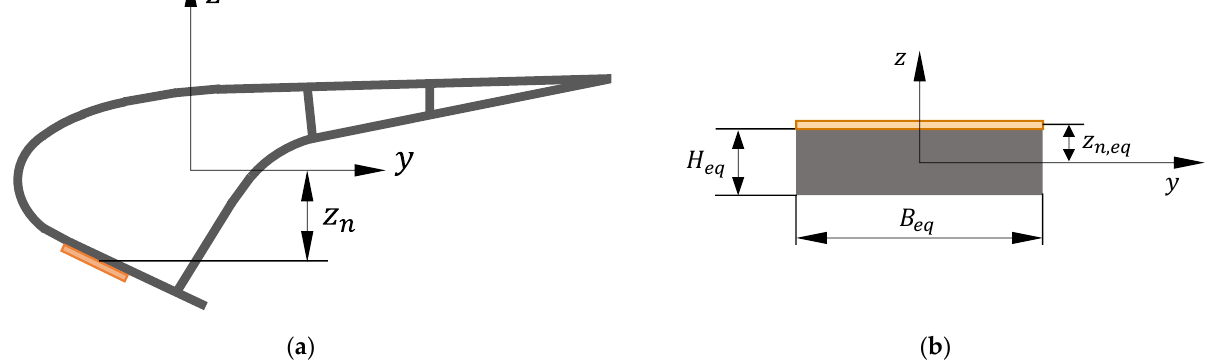
where W R = EI / z n is the module of resistance of the slat cross-section, z n is the distance from the neutral axis of the slat, E is the Young’s modulus, and I is the moment of inertia of the cross-section of the slat. Equation (26) shows that two structures loaded by the same bending moment distribution with different cross-section and Young’s modulus values may provide the same strain distribution if they have the same module of resistance. Therefore, it is possible to assume that the equivalent beam has a rectangular cross-section and that the PE patch is bonded to the upper surface of the beam. Figure 11a shows the actual cross-section of the slat, and Figure 11b schematizes the cross-section of the equivalent beam.